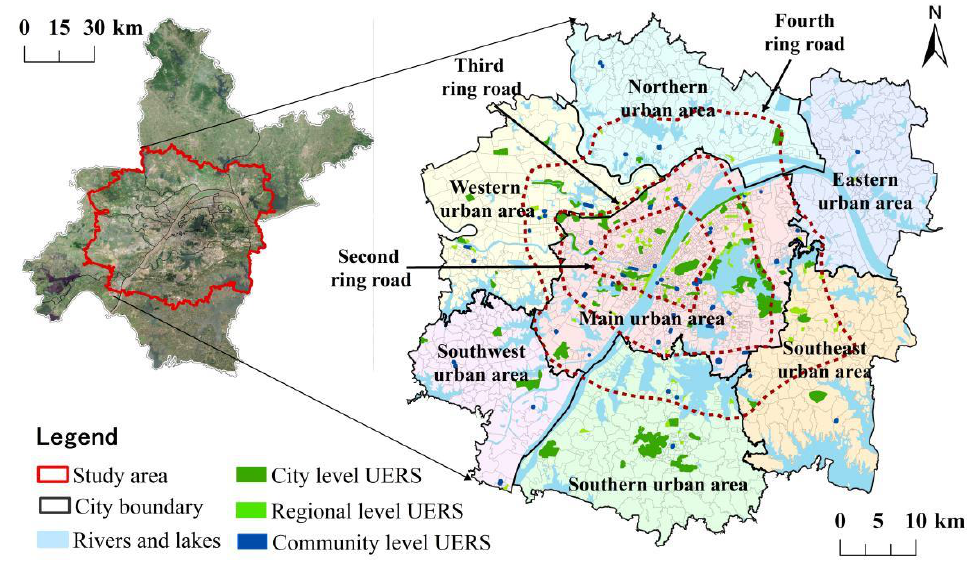
Figure 2. Map of the study